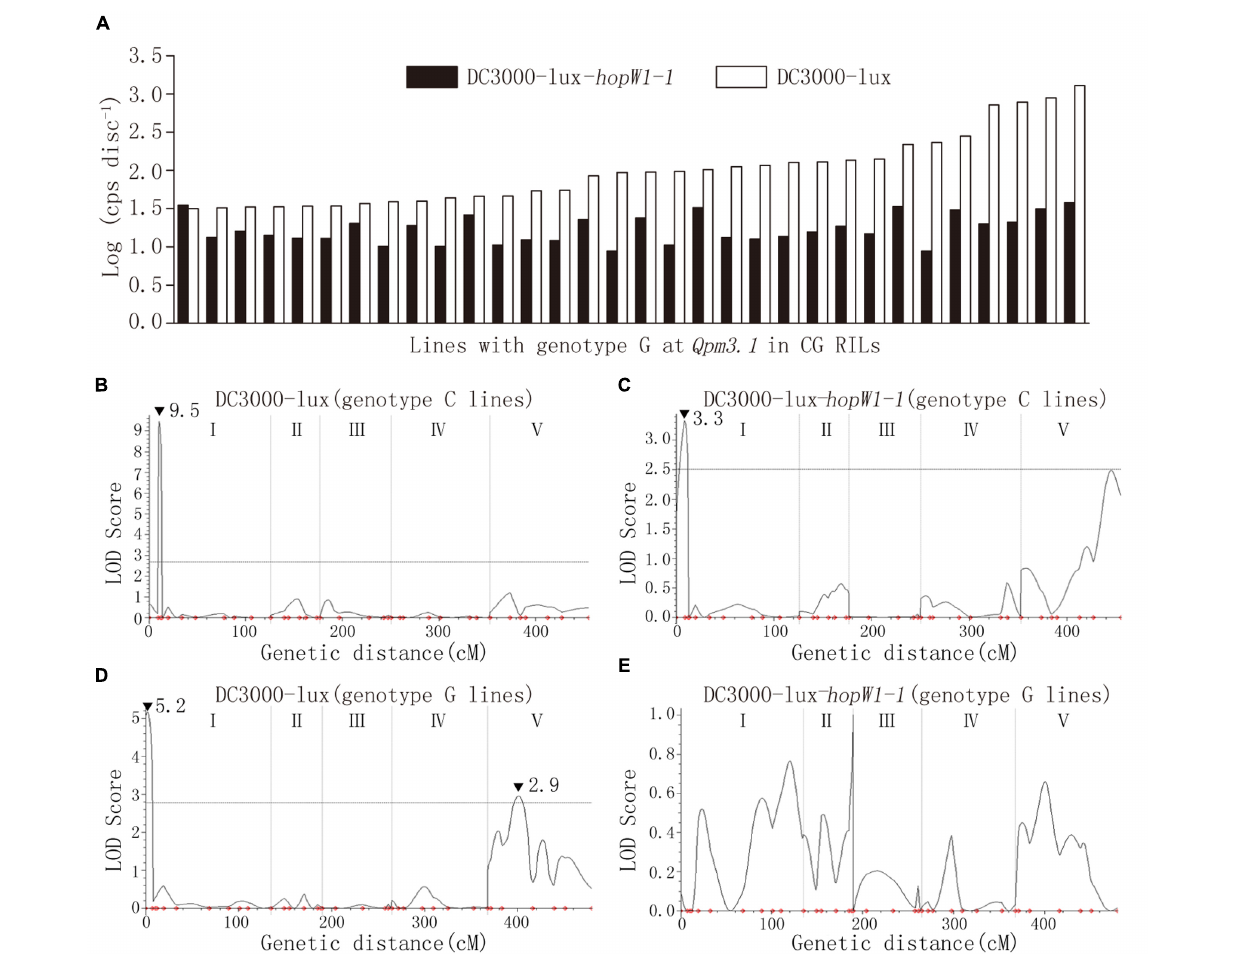
FIGURE 7 | The epistatic effect between Qpm3.1 and Qpt1.1 . (A) Comparison of the variation in levels of the bacterial population between DC3000-lux strains with or without the effector gene hopW1-1 on Col × Gie RILs carrying Qpm3.1 . (B–E) QTL analysis of resistance variation in subgroups of Col × Gie RILs. Col × Gie RILs were inoculated with DC3000-lux strains with or without hopW1-1 . Plant lines with genotypes homozygous for Col-0 (B,C) or Gie-0 (D,E) at markers NGA172 and NGA76 juxtaposing Qpm3.1 were subgrouped and used for QTL analysis. Peak LOD scores are indicated by filled triangles along with their